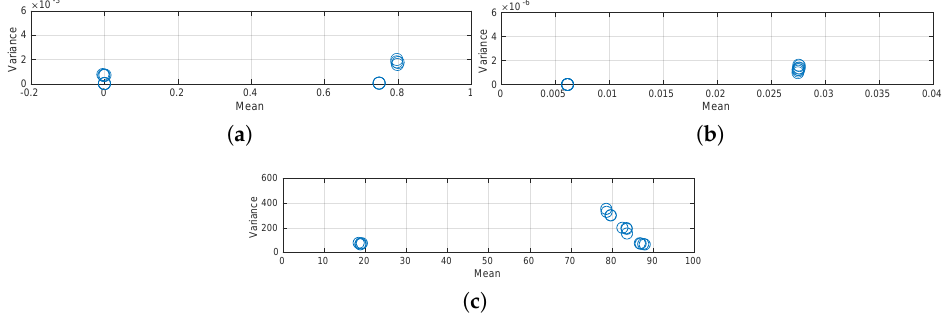
Figure 6. Homoscedasticity of population variances for the performance measures of the range filter. ( a ) Expected accuracy. ( b ) Expected uncertainty. ( c )